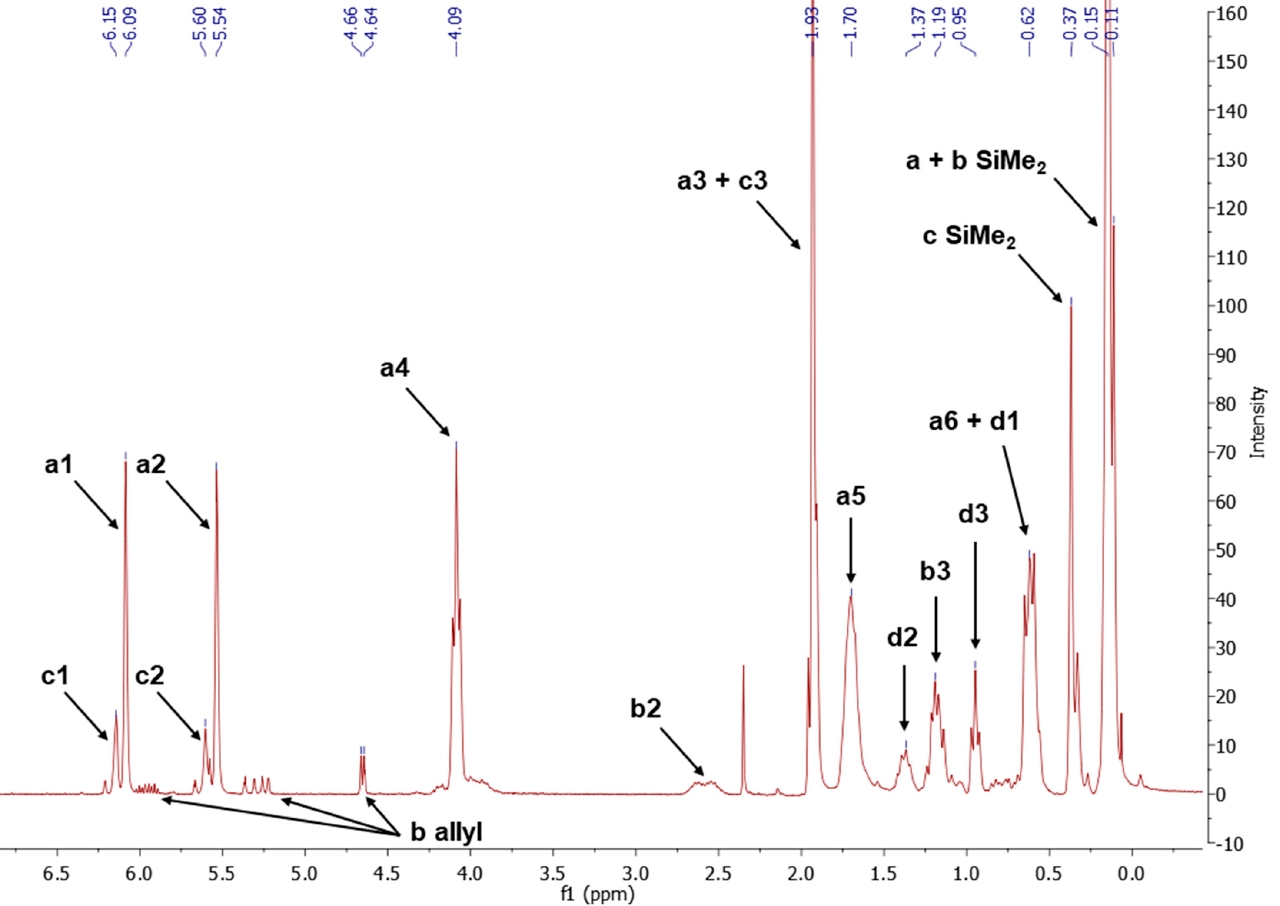
Figure 4. 1 H NMR spectrum of post-reaction mixture of allyl methacrylate hydrosilylation with SS-H.